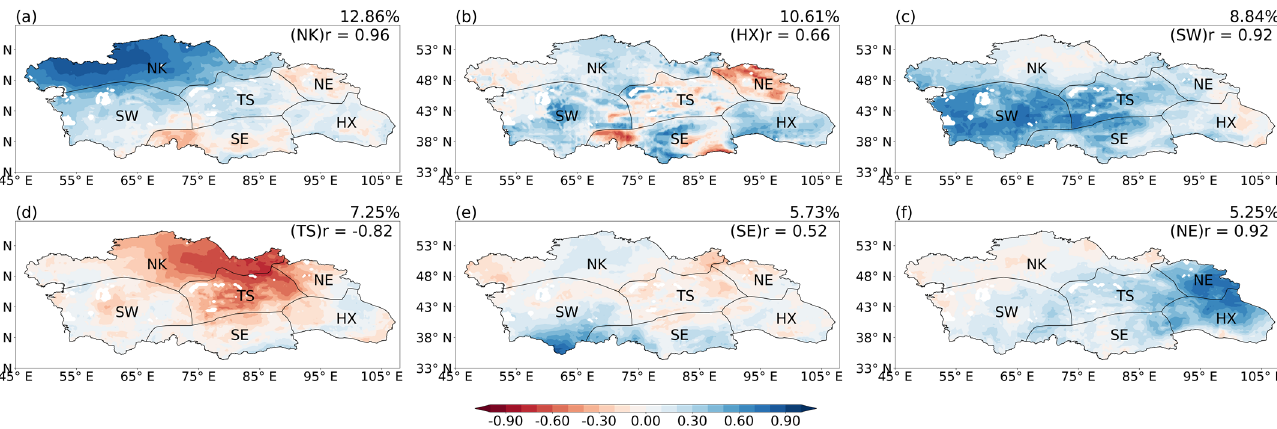
Figure 3. The first six components of the REOF variation based on SPEI12. Subplots ( a )–( f ) represent the six component results of REOF and also the partitioning basis. The r score is the Spearman correlation coefficient value between the PC score and the six subregions of SPEI12.